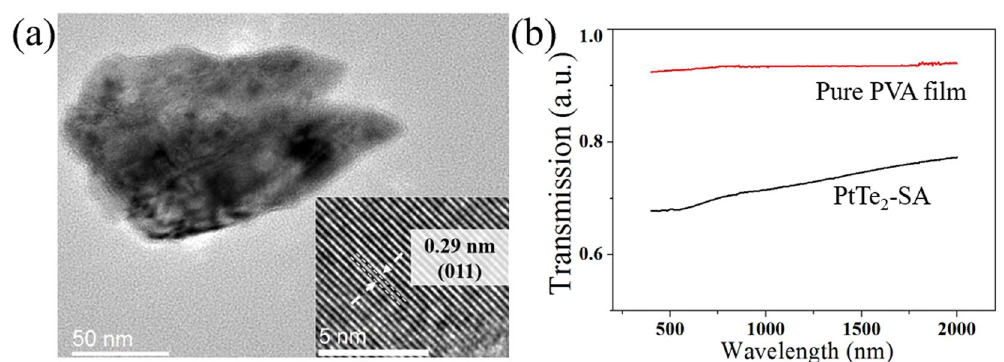
Figure 4. ( a )The FETEM image of a PtTe 2 flake with inserted corresponding high-resolution FETEM image and ( b ) the Transimmsion spectrum of the PtTe 2